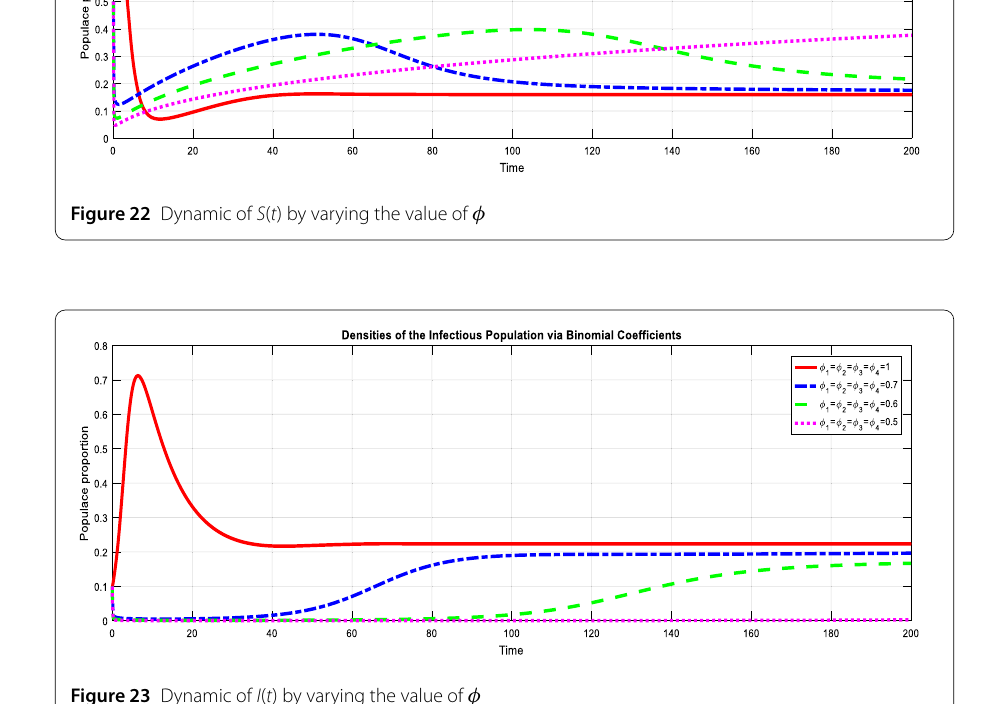
Figure 23 Dynamic of I ( t ) by varying the value of